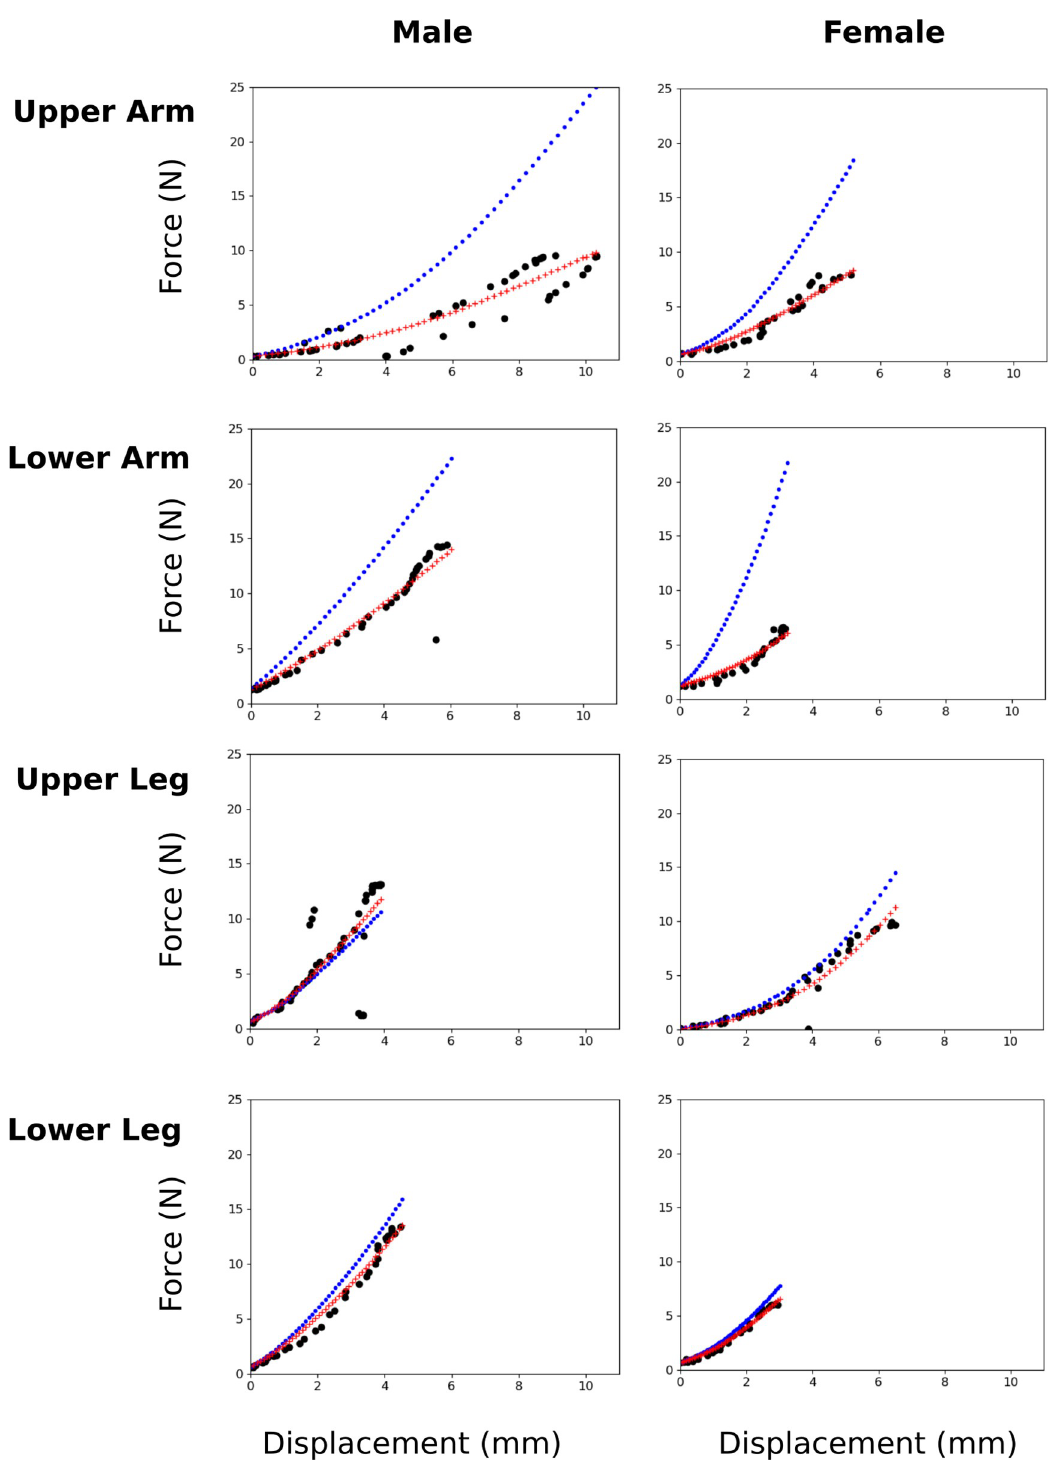
Fig 5. Force-displacement characteristic for all eight regions. Simulation results are shown with the initial guess (blue dots) vs. calibrated material parameters (red plus signs), compared to experimental data (black circles). FEBio simulation data was gathered at 100 increments over the total displacement. Plot does not show all 100 points due to cropping method, which excluded points below the initial experimental probe force and above the experimental probe displacement. Simulation displacement points cover the same range as the experimental data, but do not occur at the exact experimental displacement